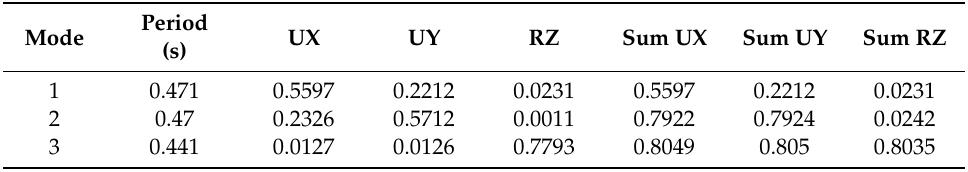
Figure 5. The 1st mode shape for T 1 = 0.471 s: ( a ) plane view and ( b ) 3D view.